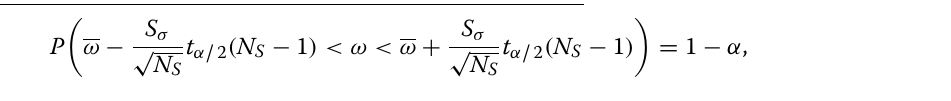
Step 4: Estimate the confidence for reliability analysis. The confidence interval is performed to quantify the con- vergence properties of the MCS methods by using stu- dent t distribution. A 100(1 implies the probability that the frequency of a true sam- ple will fall within the range the estimated values will be 100(1